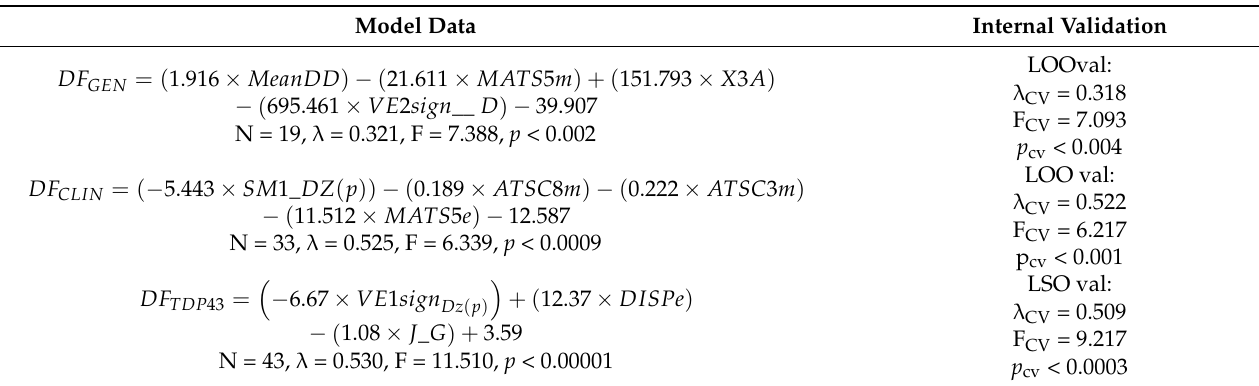
Table 1. Equations of the different discriminant models developed, statistical parameters and internal validation